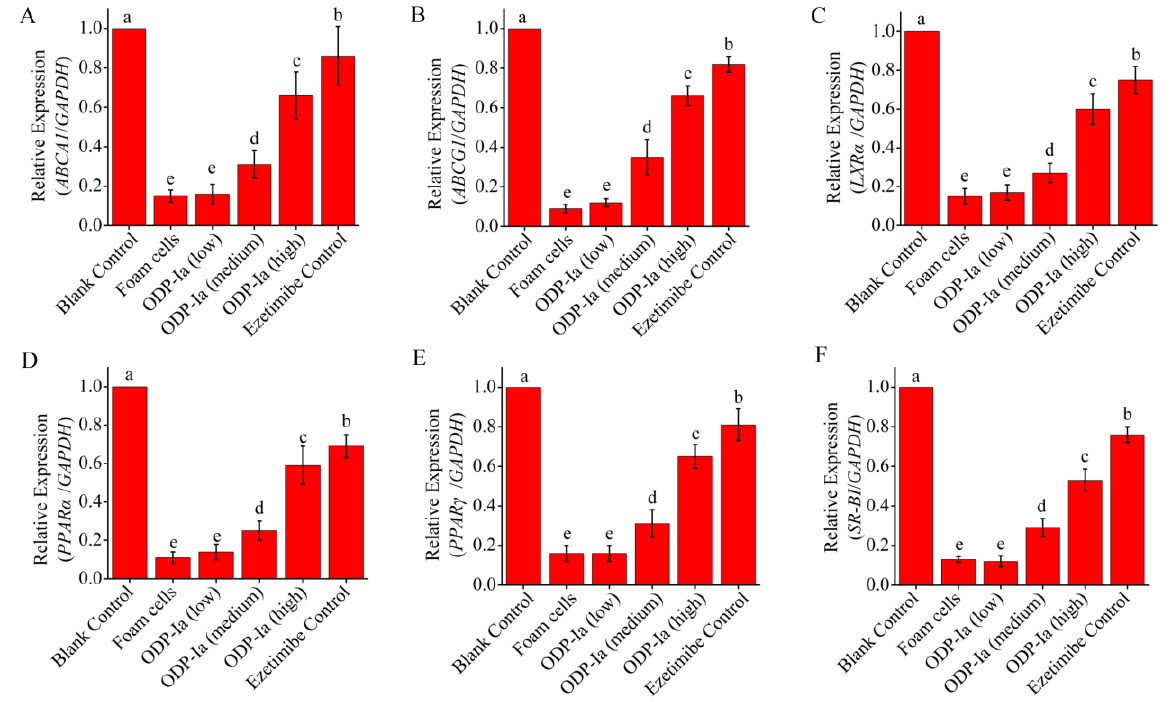
Figure 5. mRNA expression of cholesterol efflux-associated gene mediated by ODP-Ia. Values are mean ± SD, n = 9. ( A ) ABCA1 mRNA. ( B ) ABCG1 mRNA. ( C ) LXRα mRNA. ( D ) PPARα mRNA. ( E ) PPARγ mRNA. ( F ) SR-BI mRNA. Different superscript letters indicate multiple comparisons with significant differences (SNK-q test, p < 0.05).